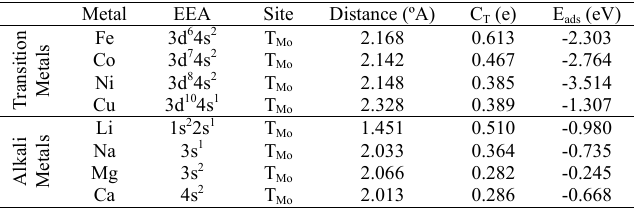
),vertical distance (A°), and amounts of charge ads at the most stable adsorption sites, from the metal atoms to mMoS 2